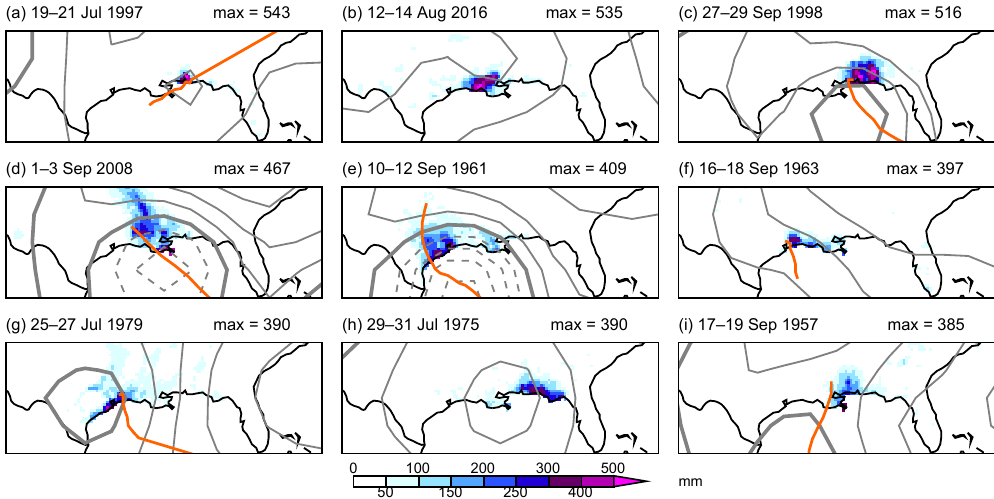
Figure 8. Top nine extreme precipitation events in the central US Gulf Coast (29–31 ◦ N, 85–95 ◦ W) for the CPC gridded precipitation analysis. The 3-day precipitation sum (millimeters, shaded colors, as in Fig. 1d), 850hPa height for the middle day (grey contours, interval 25m, 1500m contour thickened, lower contours dashed) from NCEP/NCAR Reanalysis 1 (Kalnay et al., 1996) and tropical cyclone track if system is classified as a tropical cyclone (orange line, IBTrACS). These extreme events are calculated for the 3-month period